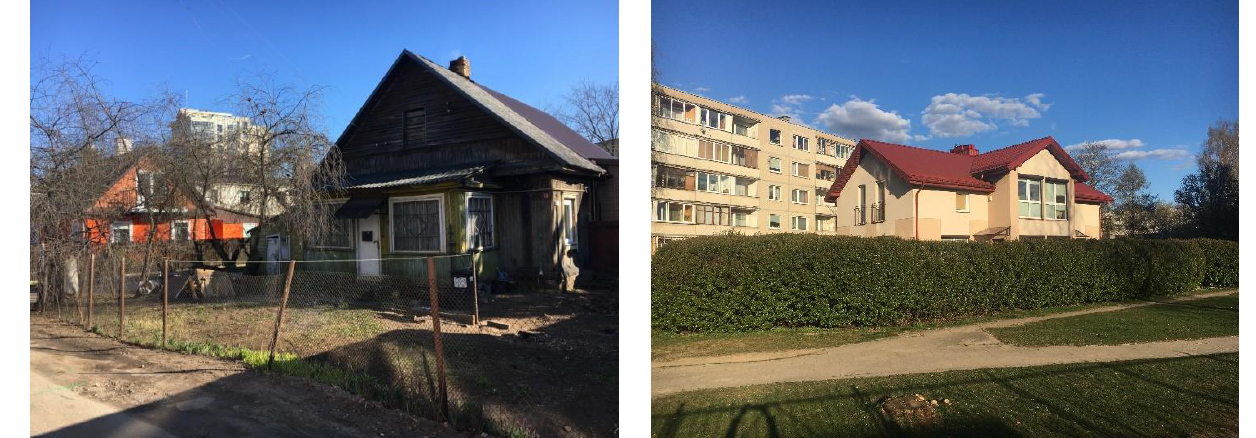
Fig. 4. The remains of rural spaces (left) and newly-rebuilt detached houses (right) inside Žirmūnai Soviet housing estate, around 1,5–2 km from Vilnius Cathedral Square (Source: